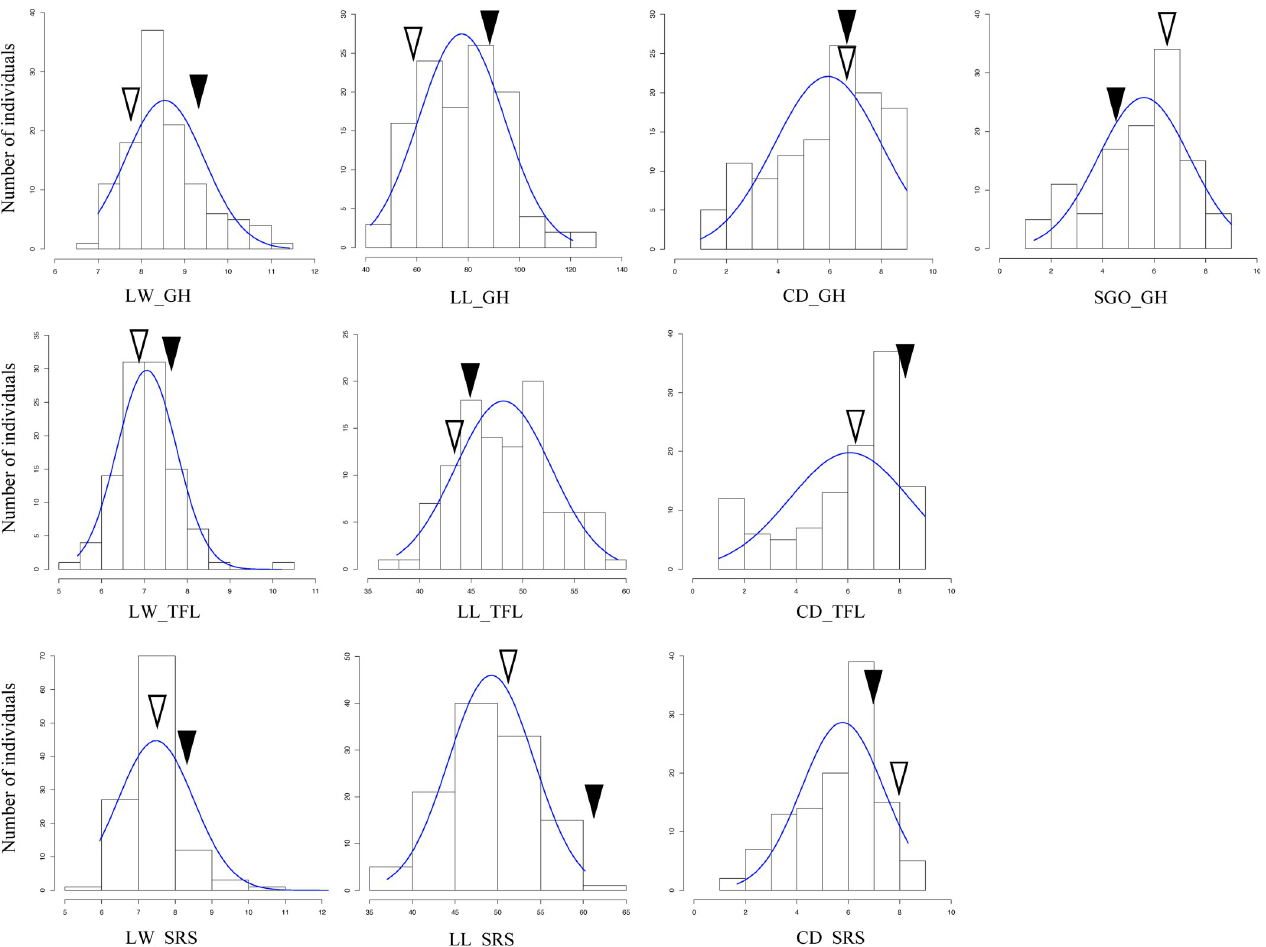
Fig 1. Distribution of leaf width (LW), leaf length (LL), canopy density (CD) and shoot growth orientation (SGO) for a St. Augustinegrass Raleigh x Seville F 1 population evaluated in greenhouse (GH) and field (TFL and SRS) experiments. Solid triangle indicates value of Raleigh and white triangle indicates value of